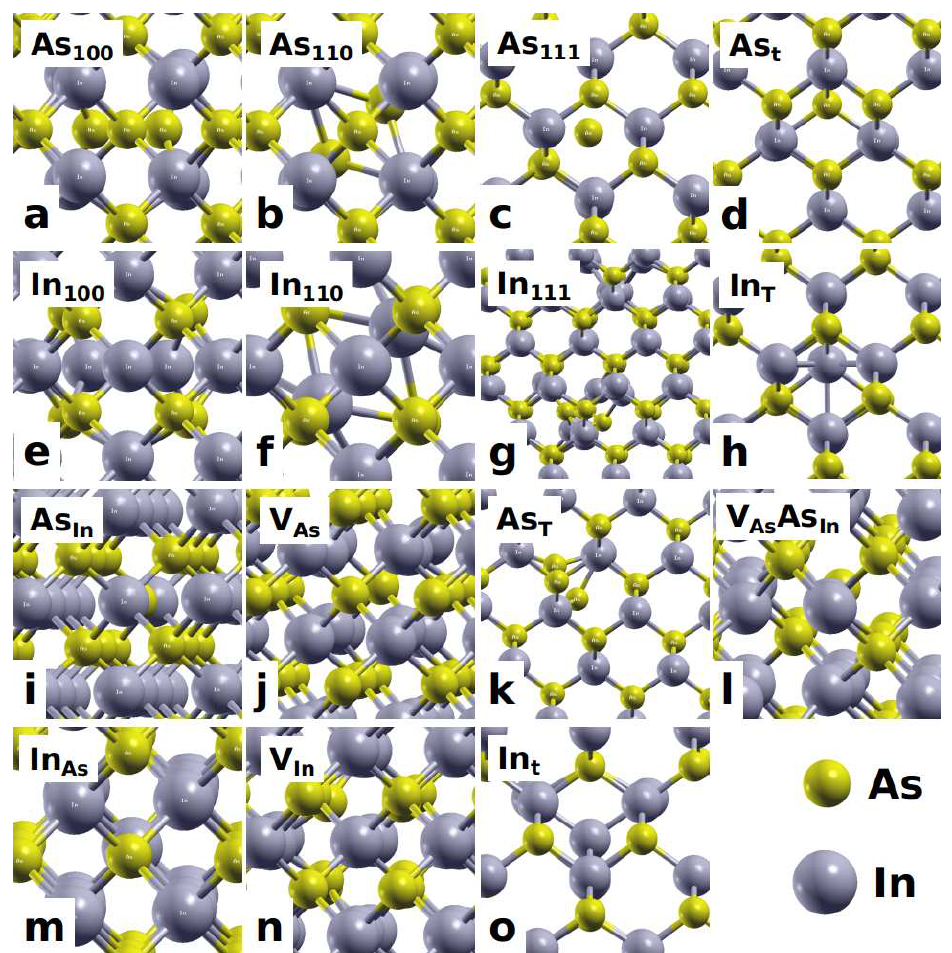
Figure 2. The atomic structures of 15 intrinsic point-defect configurations of zb -InAs after full geometry optimization according to the minimum energy in neural charge state: ( a ) As 100 , ( b ) As 110 , ( c ) As 111 , ( d ) As t , ( e ) In 100 , ( f ) In 110 , ( g ) In 111 , ( h ) In T , ( i ) As In , ( j ) V As , ( k ) As T , ( l ) V As As In , ( m ) In As , ( n ) V In , ( o ) In t . Here, the small yellow spheres denote As atoms, while the large silver spheres denotes In atoms.